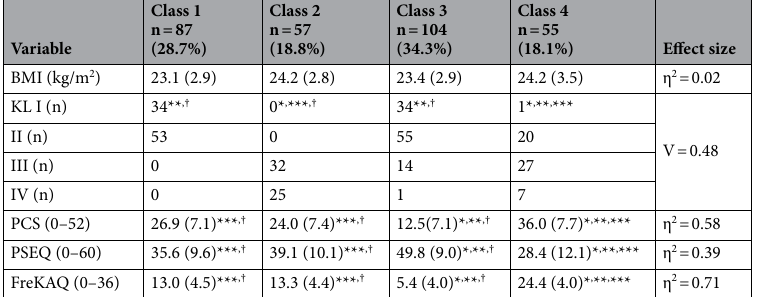
Table 3. Descriptive statistics of the 4 clusters derived from cluster variable. Values are the mean ± SD. BMI body mass index, KL Kellgren/Lawrence, PCS Pain Catastrophizing Scale, PSEQ Pain Self-Efficacy Questionnaire, FreKAQ Fremantle Knee Awareness Questionnaire. *Indicates significant difference compared with Class 1. **Significant difference compared with Class 2. ***Significant difference compared with Class 3. † Significant difference compared with Class 4. P values of less than 0.012 for Bonferroni post hoc tests and Chi- squared test, and 0.0083 for Wilcoxon rank sum.